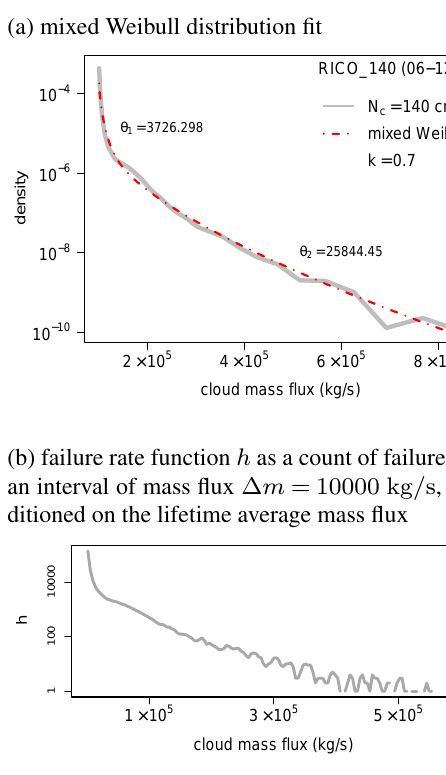
Figure 4. Semi-logarithmic plots of the cloud rate density distri- bution of cloud-base mass flux and the cloud failure rate function. These plots correspond to the RICO-140 simulation time frame of 6–12h. The cloud rate density distribution is fitted using the mixdist R package (R Core Team, 2013), and the distribution shape param- eter is set as equal for both distribution modes: k 1 = k 2 = k